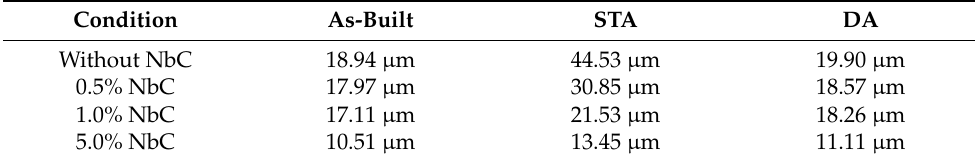
Figure 8. Overall EBSD inverse pole figures of different specimens. ( a ) as-built without NbC, ( b ) STA without NbC, ( c ) DA without NbC, ( d ) as-built with 0.5% NbC, ( e ) STA of 0.5% NbC, ( f ) DA of 0.5% NbC, ( g ) as-built of 1.0% NbC, ( h ) STA of 1.0% NbC, ( i ) DA of 1.0% NbC, ( j ) as-built of 5.0% NbC, ( k ) STA of 5.0% NbC, and ( l ) DA of 5.0% NbC. Table 5. Average grain diameter of different specimens.